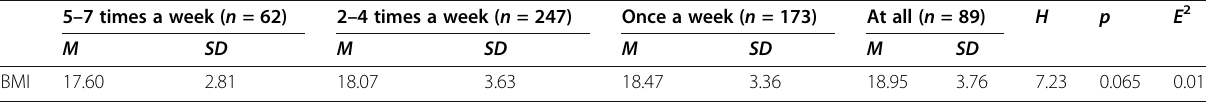
Table 6 Average results, standard deviations and significance of differences in relations to body mass index depending on the frequency of the use of sports facilities